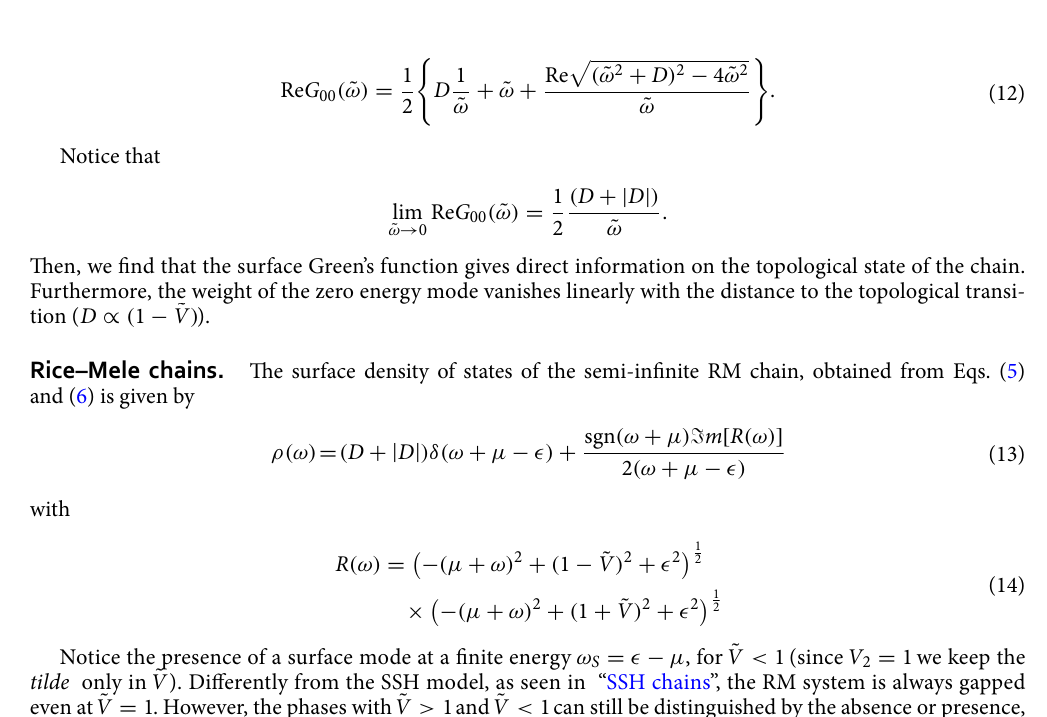
Figure 1. ( a ) Density of states at the surface of the semi-infinite SSH chain and ( b ) real part of the surface Green’s function. In the topological phase (red, dashed), the trivial phase (black, continuous) and at the topological transition (blue, dotted). We took V 2 = 1 , such that ˜ ω = ω